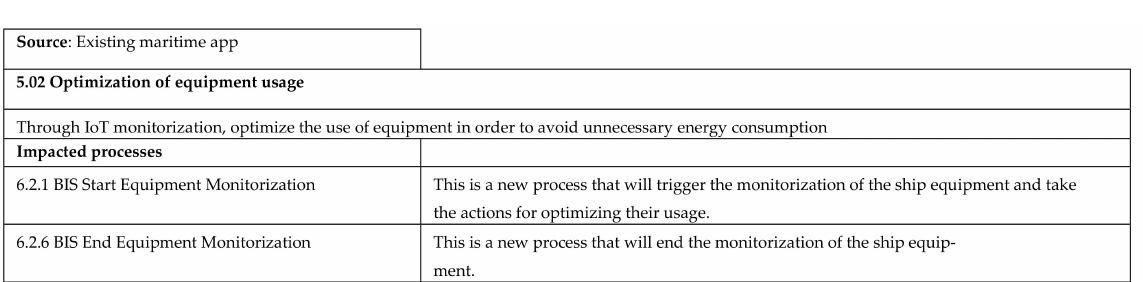
Figure A36. Container tracking data sheet.